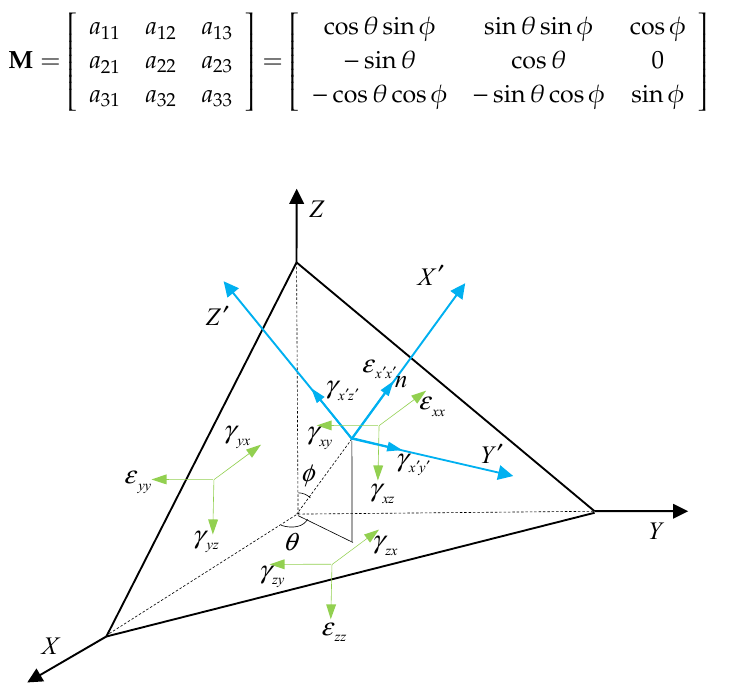
Figure 10. The strains on the candidate critical plane in a three-dimensional coordinate system.